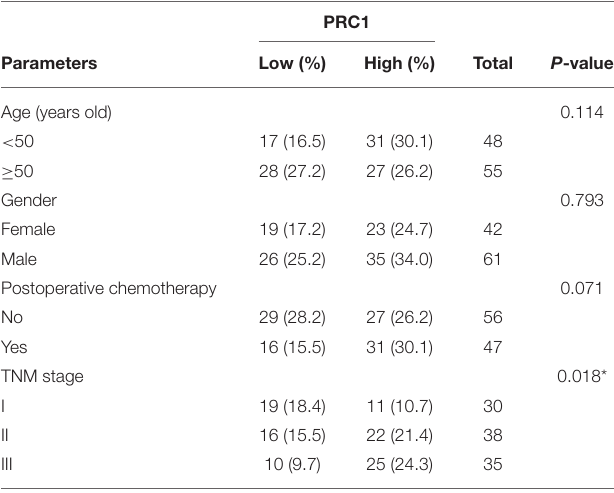
TABLE 1 | PRC1 staining and clinicopathological characteristics of 103 hepatocellular carcinoma